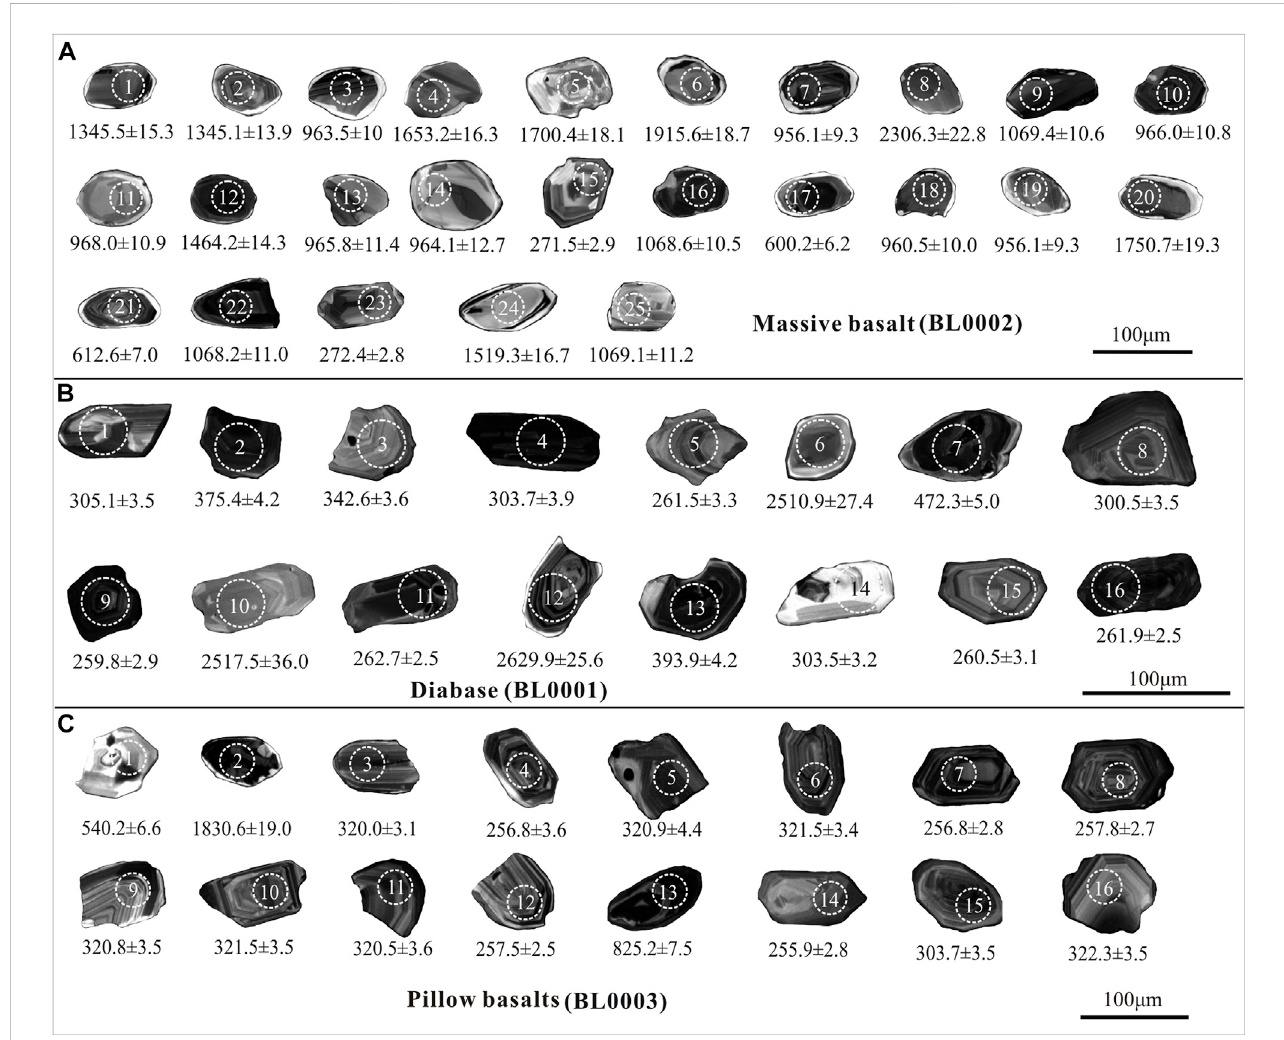
FIGURE 4 Cathodoluminescence images of zircons from basic igneous rocks in the Bairin Right Banner area, Inner Mongolia. (A) massive basalt (BL0002); (B) diabase (BL0001); (C) pillow basalt (BL0003).